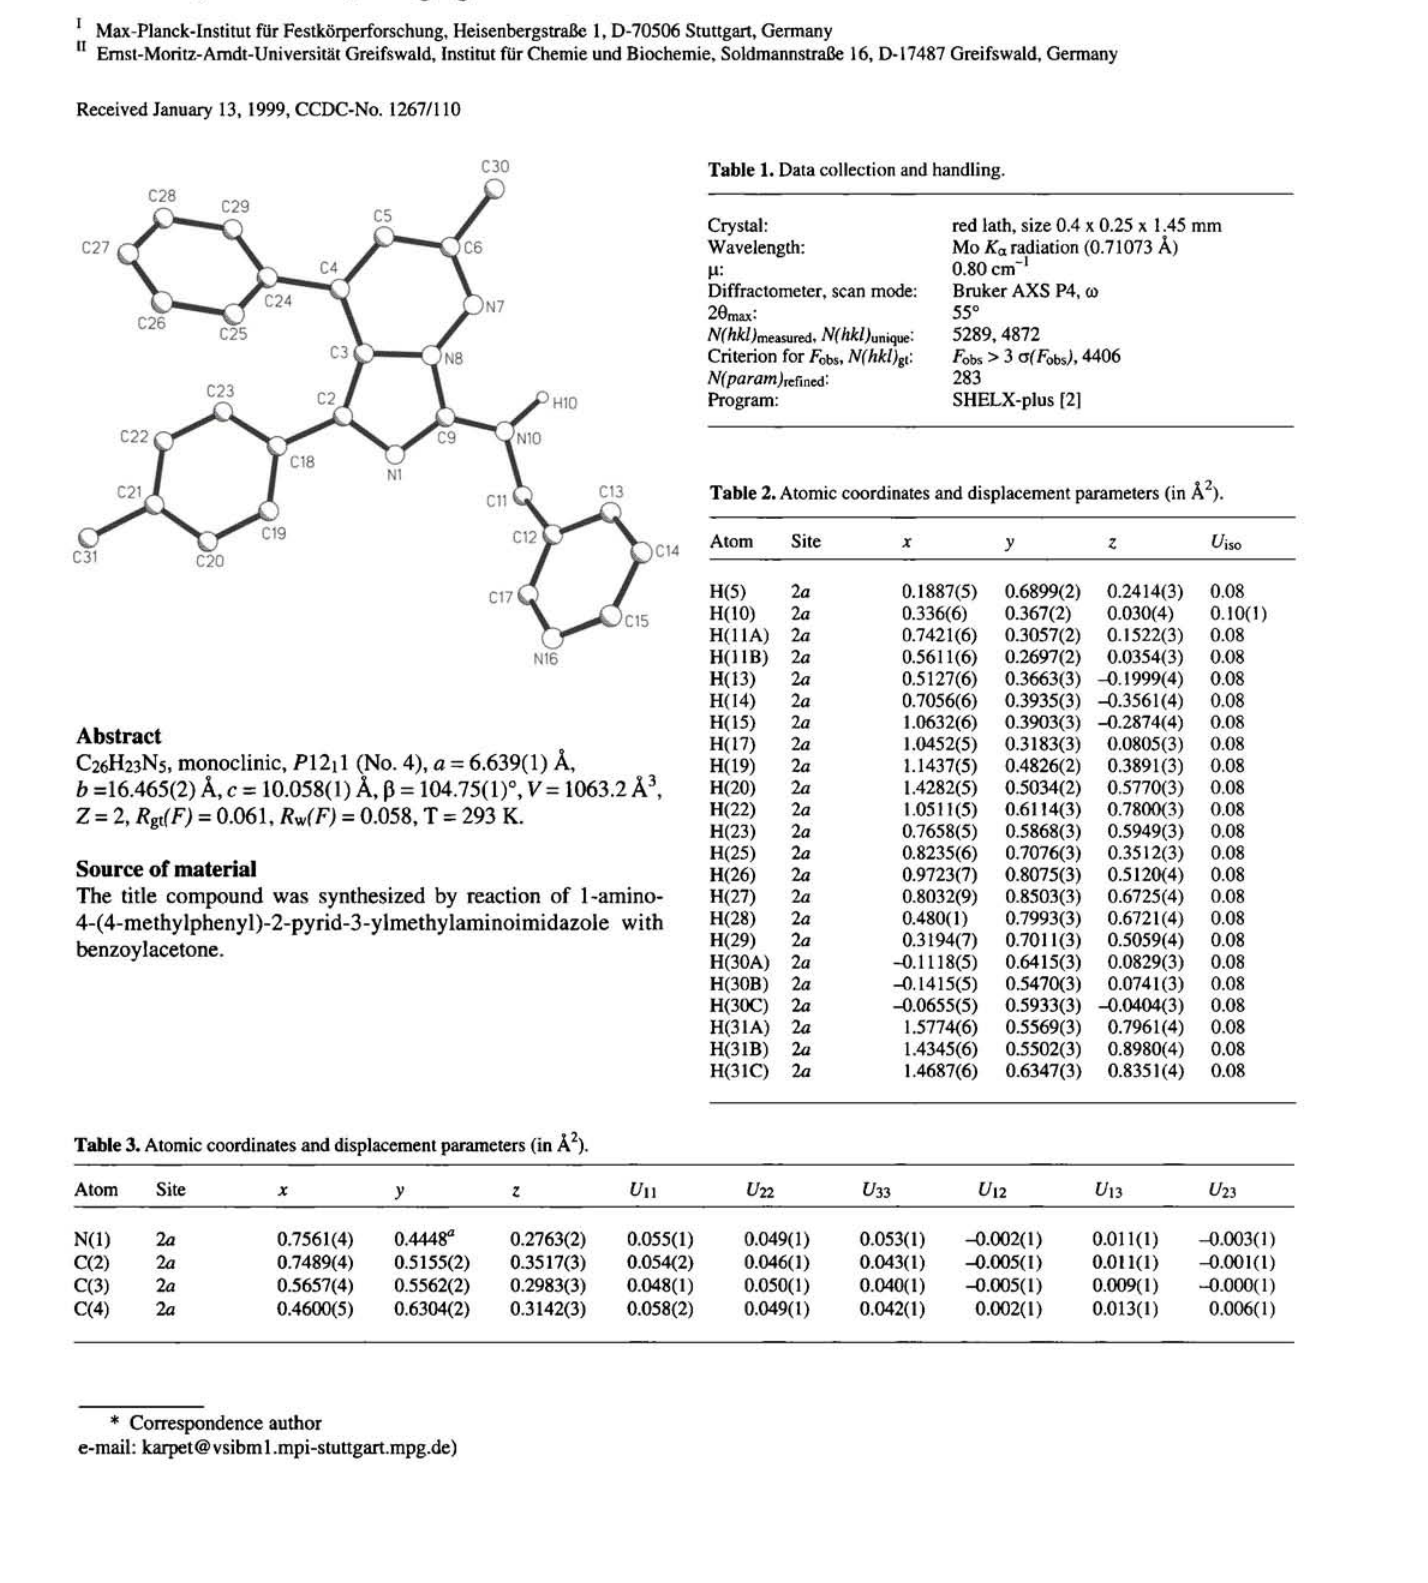
Table 1. Data collection and handling.